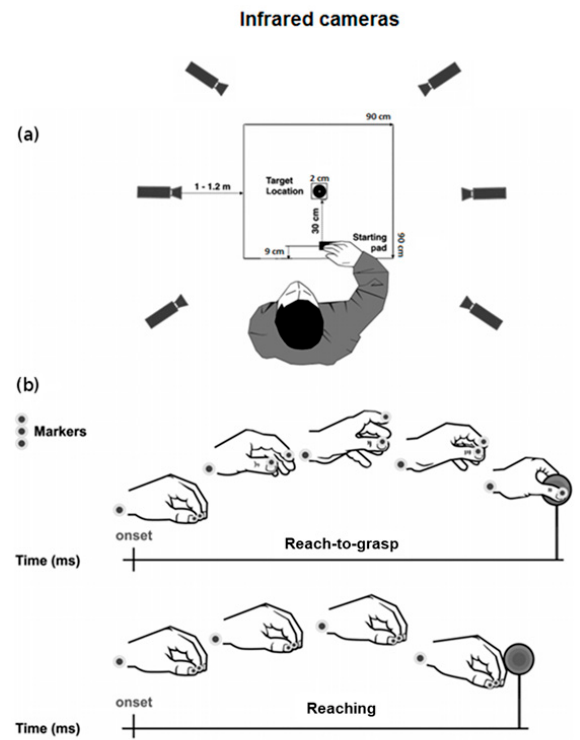
Figure 2. Schematic representation for ( a ) the experimental set-up and ( b ) the reach-to-grasp and the reaching movements together with markers positioning. Adapted from [12].